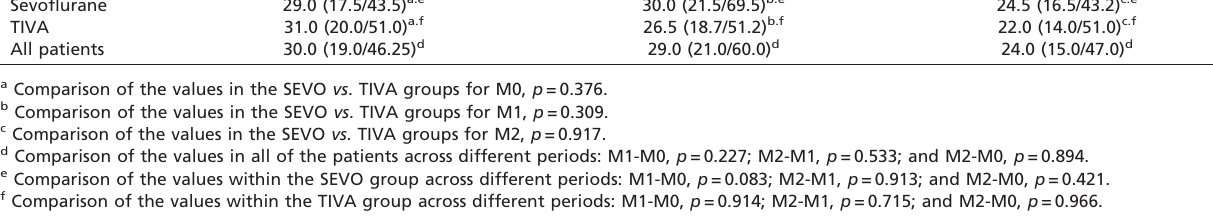
Table 2 - The median neutrophil gelatinase-associated lipocalin levels (ng/mL) (1 st and 3 rd quartiles) before anesthesia, 6 hours after pneumoperitoneum and 24 hours after pneumoperitoneum in all of the patients, separated according to type of anesthesia, total intravenous or inhalation anesthesia sevoflurane. GROUP BEFORE ANESTHESIA